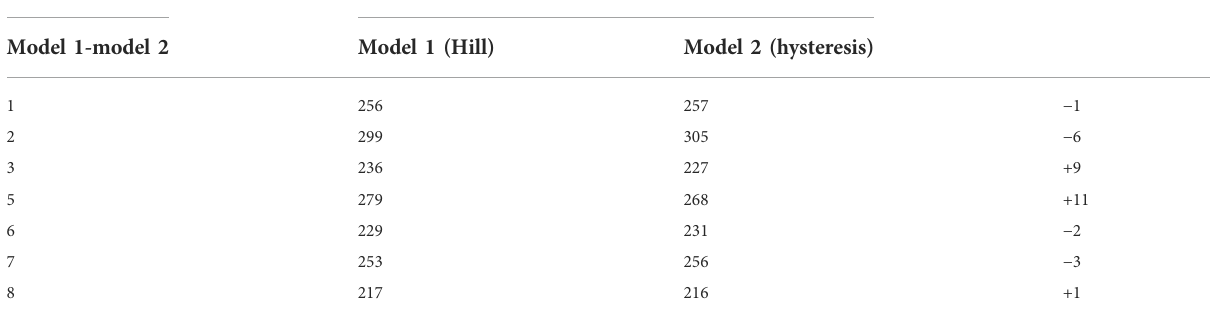
TABLE 8 Values of the Akaike Information Criterion corrected for small sample size (AICc) is presented for CS subjects. Smaller AICc values indicate a better fi t. The AICc values are not uniformly less for one model over the other.